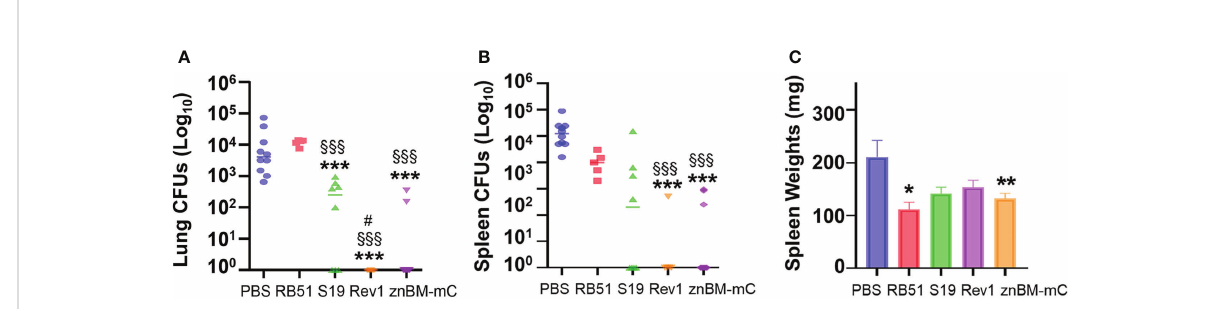
FIGURE 2 Mucosal vaccination with znBM-mC or Rev 1 elicits protective immunity superior to RB51 or S19 against a wt B. melitensis 16M challenge. All groups of BALB/c mice were vaccinated via the oral route with 10 9 CFUs each with B. abortus RB51, B. abortus S19, B. melitensis Rev 1, or znBM-mC on day 0 as described in Figure 1B. The vehicle control group was orally dosed with sPBS only. All mice were IN boosted with their respective vaccines on day using 5 × 10 8 CFUs, and then subjected to pulmonary challenge with 5 × 10 4 CFUs of wt B. melitensis 16M on day 56. On day 84, lungs and spleens were collected, weighed, and homogenized in sPBS with serial dilutions plated on Farrell ’ s media for CFU enumeration. (A) Both Rev 1- and znBM-mC- vaccinated mice showed signi fi cant reduction in lung colonization compared to PBS-dosed and RB51-vaccinated mice; Rev 1-vaccinated mice showed signi fi cant reduction to S19-vaccinated mice. (B) Both Rev 1- and znBM-mC-vaccinated mice showed signi fi cant reduction in splenic colonization compared to PBS-dosed and RB51-vaccinated mice. (C) Only znBM-mC- and RB51-vaccinated mice showed a signi fi cant reduction in splenic weights compared to PBS controls. Data represent two independent experiments with fi ve to seven mice per group; *p <0.05, **p <0.005, and ***p <0.0005 versus PBS-dosed mice; §§§ p <0.001 vs. RB51-vaccinated mice; and # p <0.05 vs. S19-vaccinated